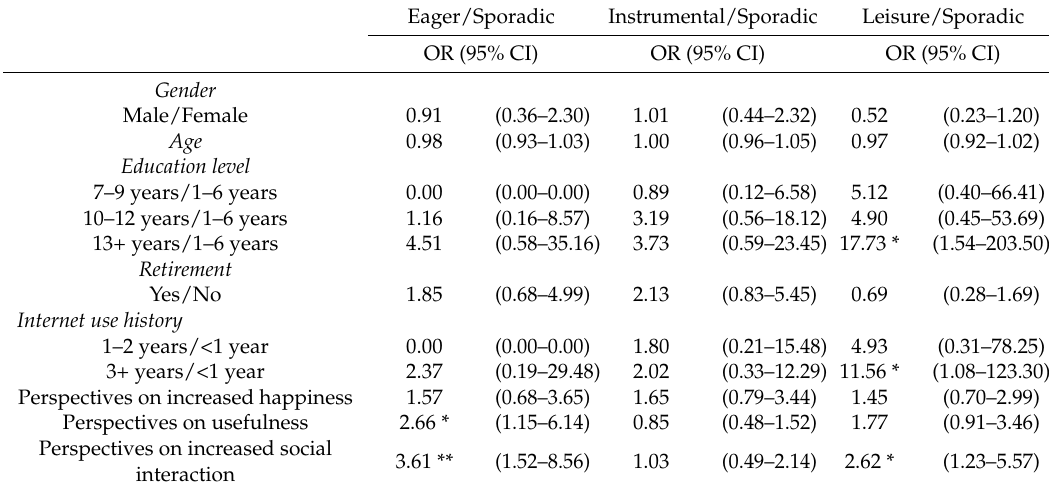
Table 3. Factors predicting participants in different Internet usage types.